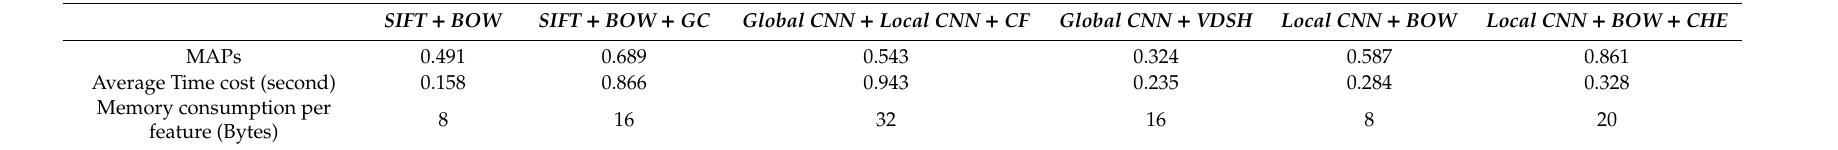
Table 2. Comparison between di ff erent methods on the Dupimage